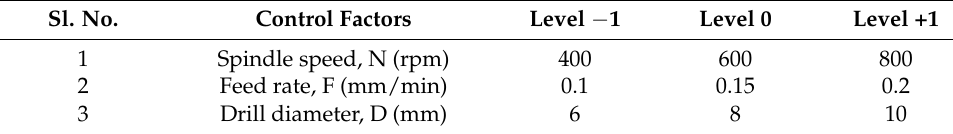
Figure 5. Light microscope used for hole quality assessment. Table 1. Factors and their level combination for drilling.